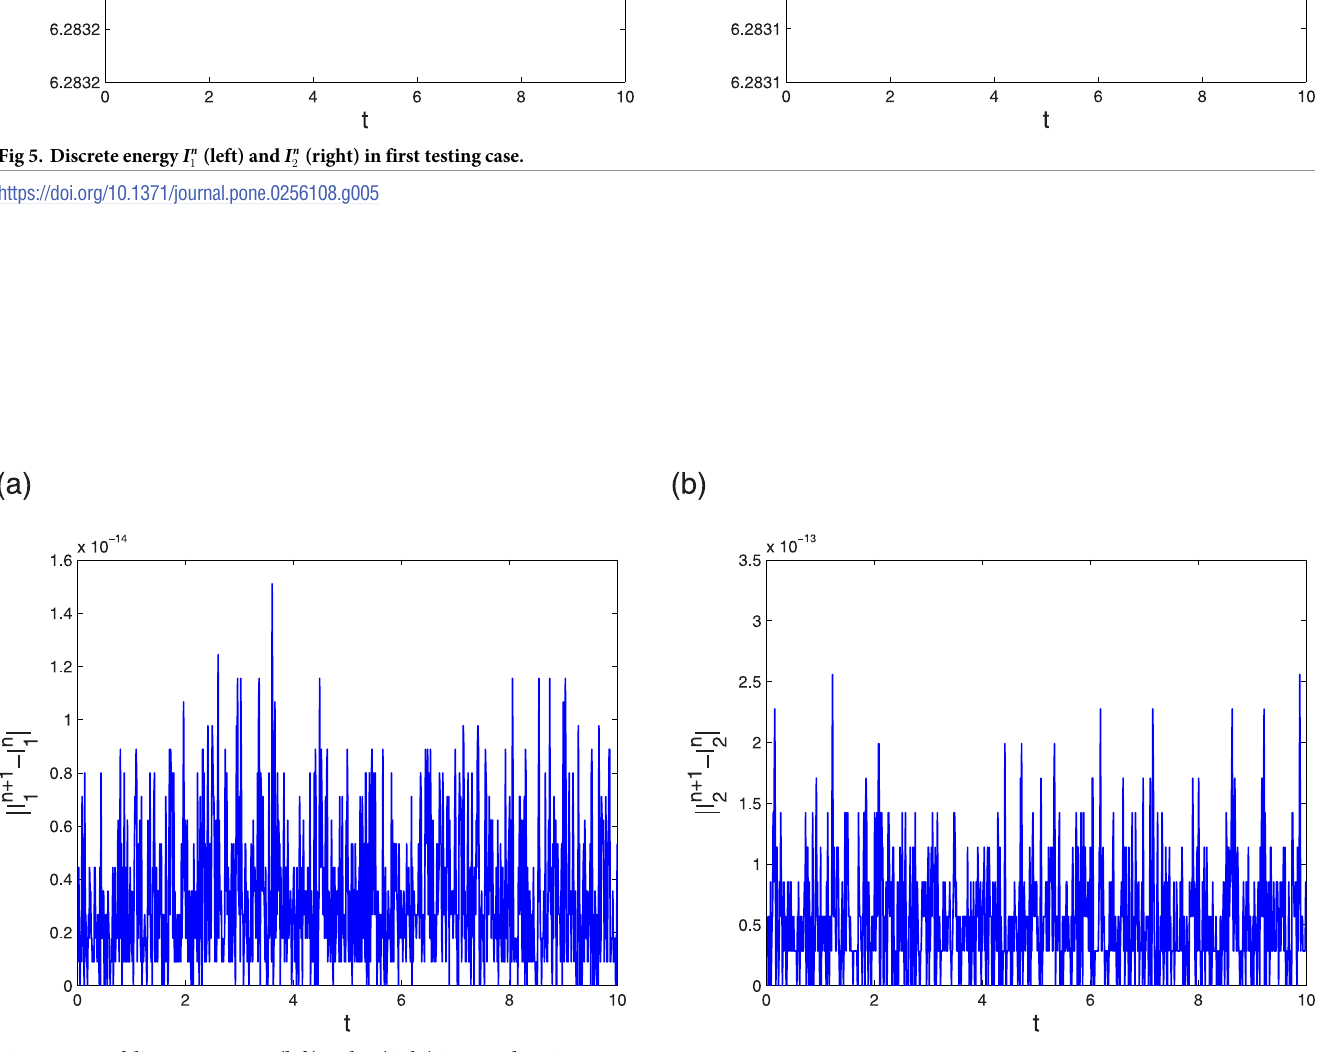
Fig 6. Errors of discrete energy I n